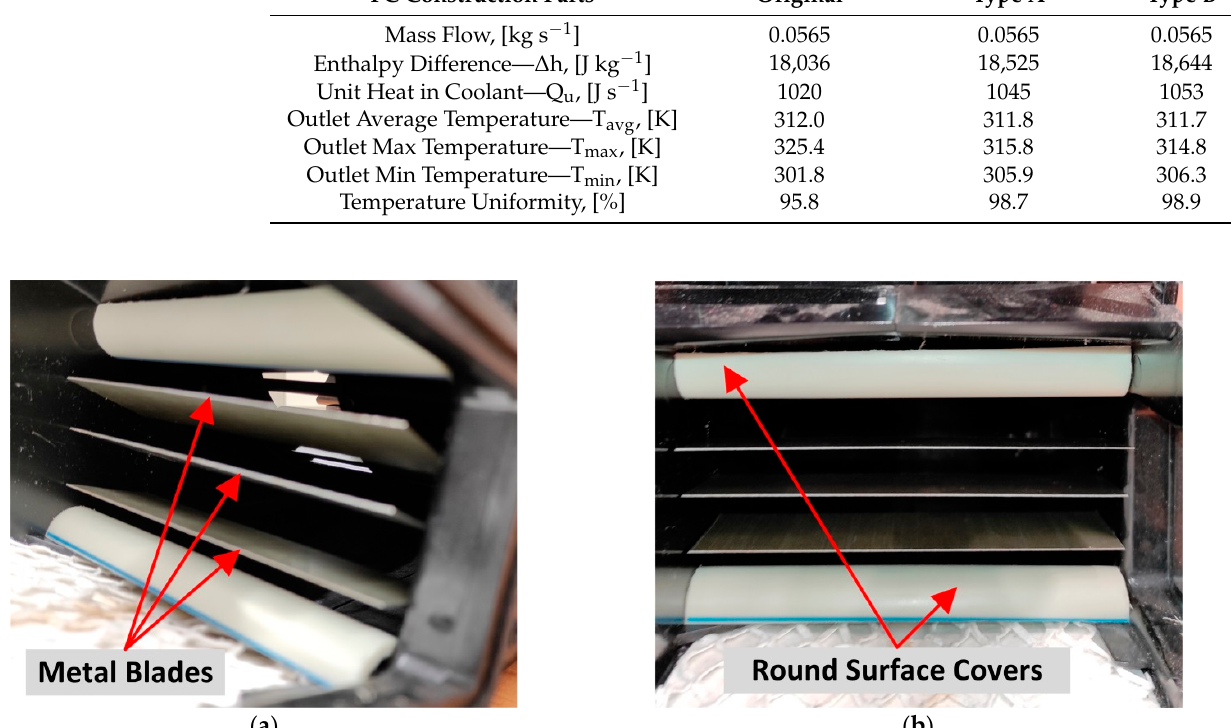
Figure 17. Adjustment of cooling duct close to the fan outlet seen in ( a ) side view and ( b ) front view.